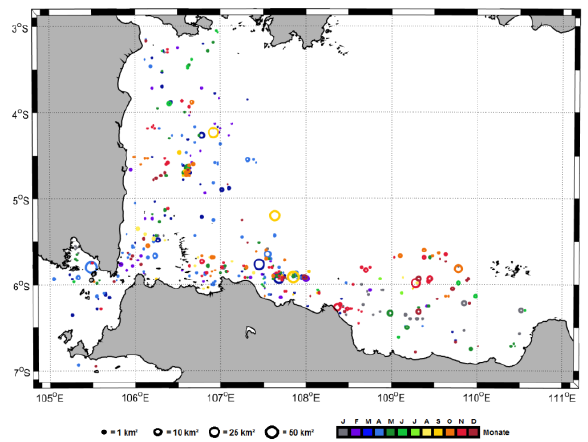
Figure 8. Map of oil pollution found on Sentinel-1A/B SAR-C imagery of the ROI ‘W Java Sea’. Circle diameters are proportional to the spill sizes, and the color coding denotes the monthly distribution (Meier, 2016).